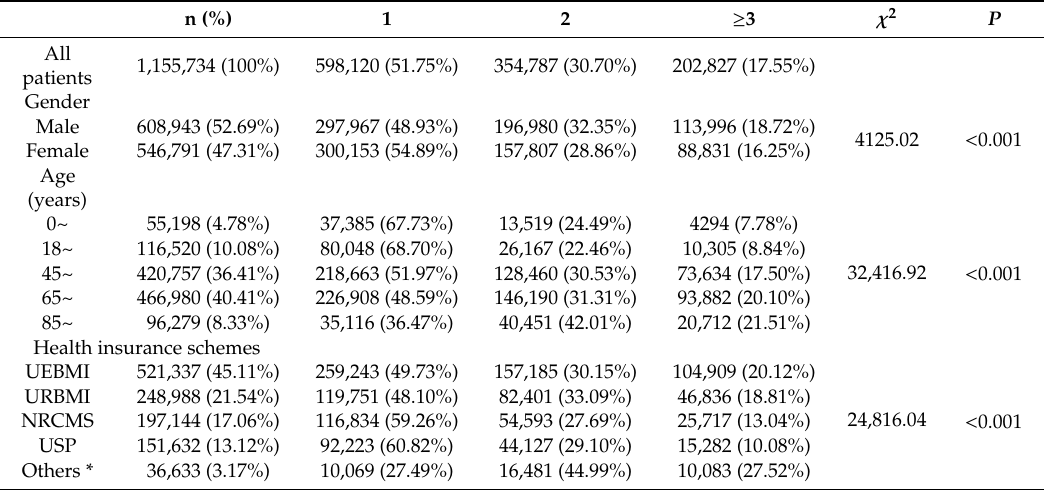
Table 1. Descriptive characteristics of the patients by the number of